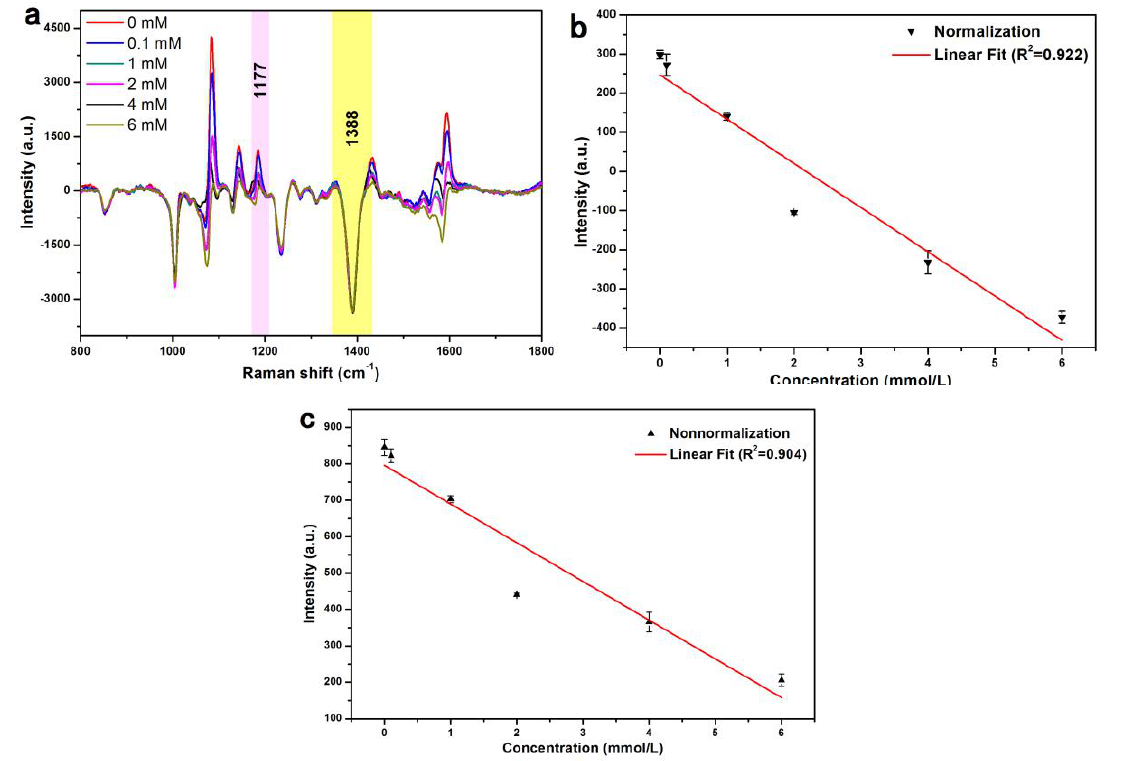
Figure 6. ( a ) Normalized SERS spectra of Au@Ag NPs recorded in the presence of different glucose levels in urine ( b ) the working curve for the peak at 1177 cm –1 based on normalized SERS spectra, ( c ) the working curve of the peak at 1177 cm –1 based on original SERS spectra.